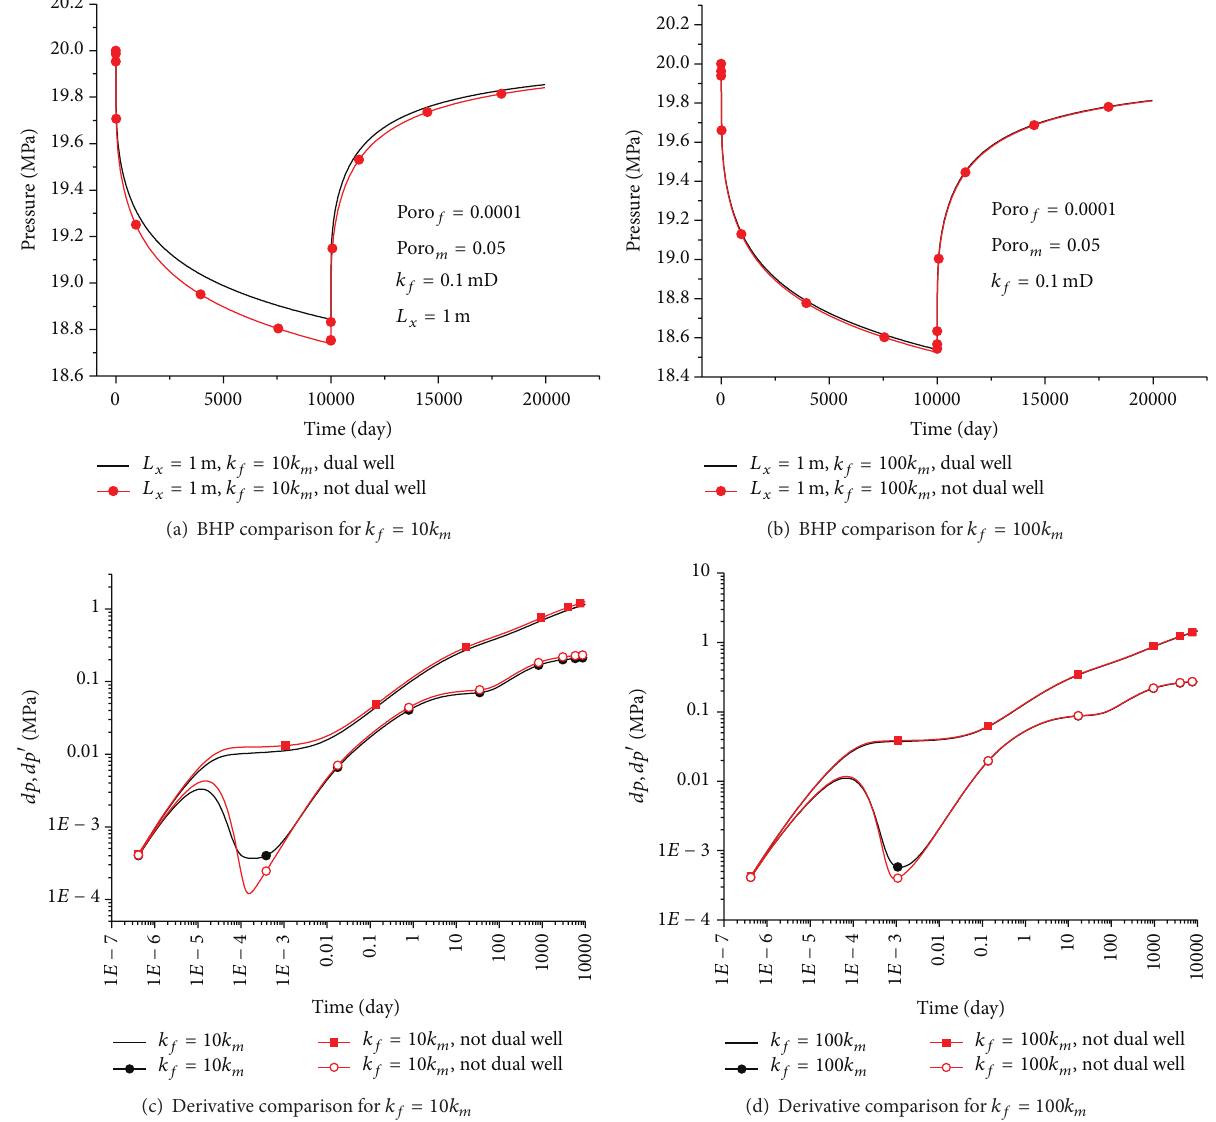
Figure 3: Effect of flow during matrix and wellbore on BHP under 𝐿 𝑥 = 1 m and 𝑄 = 10000 m 3 /